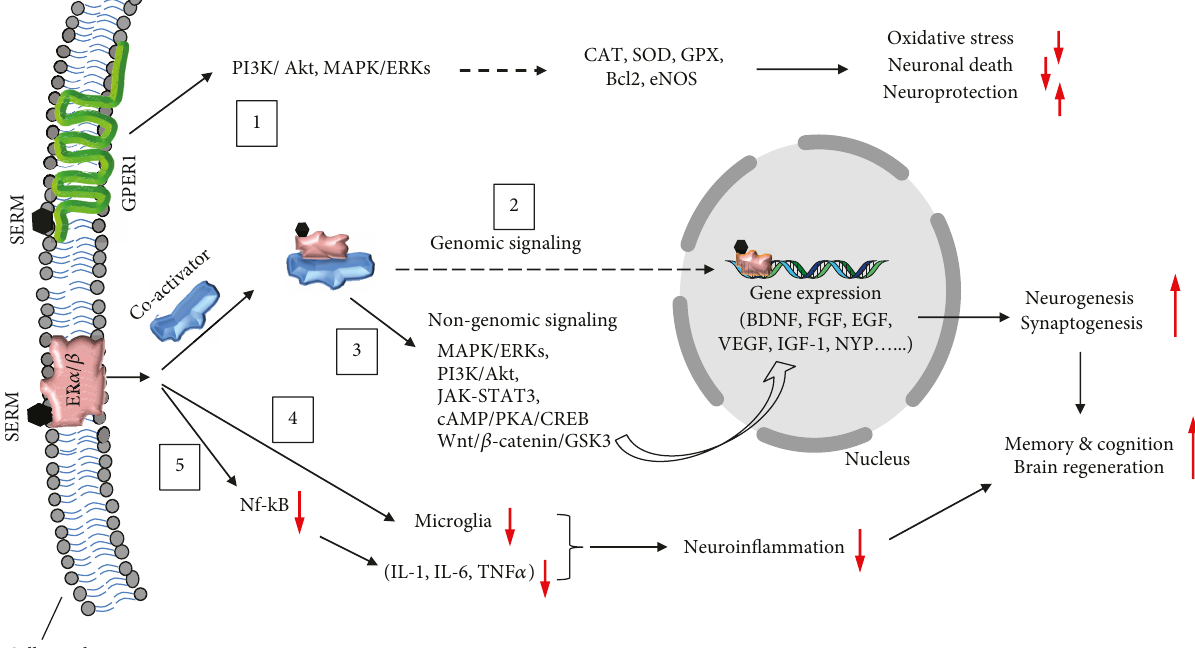
Figure 1: Possible signaling mechanisms of SERM actions in neurocognition and neuroprotection. Over the last few years, others and we have shown that SERMs can mediate their actions by initiating genomic (gene expression) and/or nongenomic signaling that involve kinases and phosphatases. In CNS tissues, SERMs can bind and activate both classical estrogen receptors- α and β (ER α or ER β ) as well as nonclassical transmembrane G protein-coupled ER (GPER1). Via agonist action at GPER1, SERMs can activate the PI3K/Akt and MAPK/ERK pathways (Figure 1, box 1), which have been shown to be involved in neuroprotection and reduction of oxidative stress and neuronal cell death by increasing the expression of antioxidant enzymes (CAT, SOD, GPx, and eNOS), Bcl2, and other trophic factors. Via agonist action at the classical ER α or ER β , SERMs can activate gene expression/genomic signaling (Figure 1, box 2) of various growth factors and proteins involved in synaptic plasticity, neurogenesis, memory, and cognition. SERMs can also enhance interaction of ER α or ER β with MNAR/PELP1, a sca ff old/coactivator protein highly expressed in neurons and astrocytes [165,166]. The resultant ER-MNAR/PELP1 complex can then initiate nongenomic signaling by activating the PI3K/Akt, MAPK/ERK, and Wnt/ β -catenin/GSK3 β signaling pathways (Figure 1, box 3). These pathways have been shown to regulate neurogenesis, synaptogenesis, and cognitive behaviors in the normal and model animals of diseases. SERMs can reduce brain in fl ammation by acting on astroglia via ER α or ER β . They can reduce microglia proliferation (Figure 1, box 4) as well as production of in fl ammatory cytokines and chemokines including IL-1, IL-6, and TNF α via inhibition of nuclear factor-kappa-B (Nf-KB) transactivation (Figure 1, box 5). Inhibition of this pathway has been shown to induce neuroprotection and reduce neuronal cell death in various cellular and animal models of brain injury. Red arrows indicate increase (upward) or decrease (downward) in the magnitude of response by